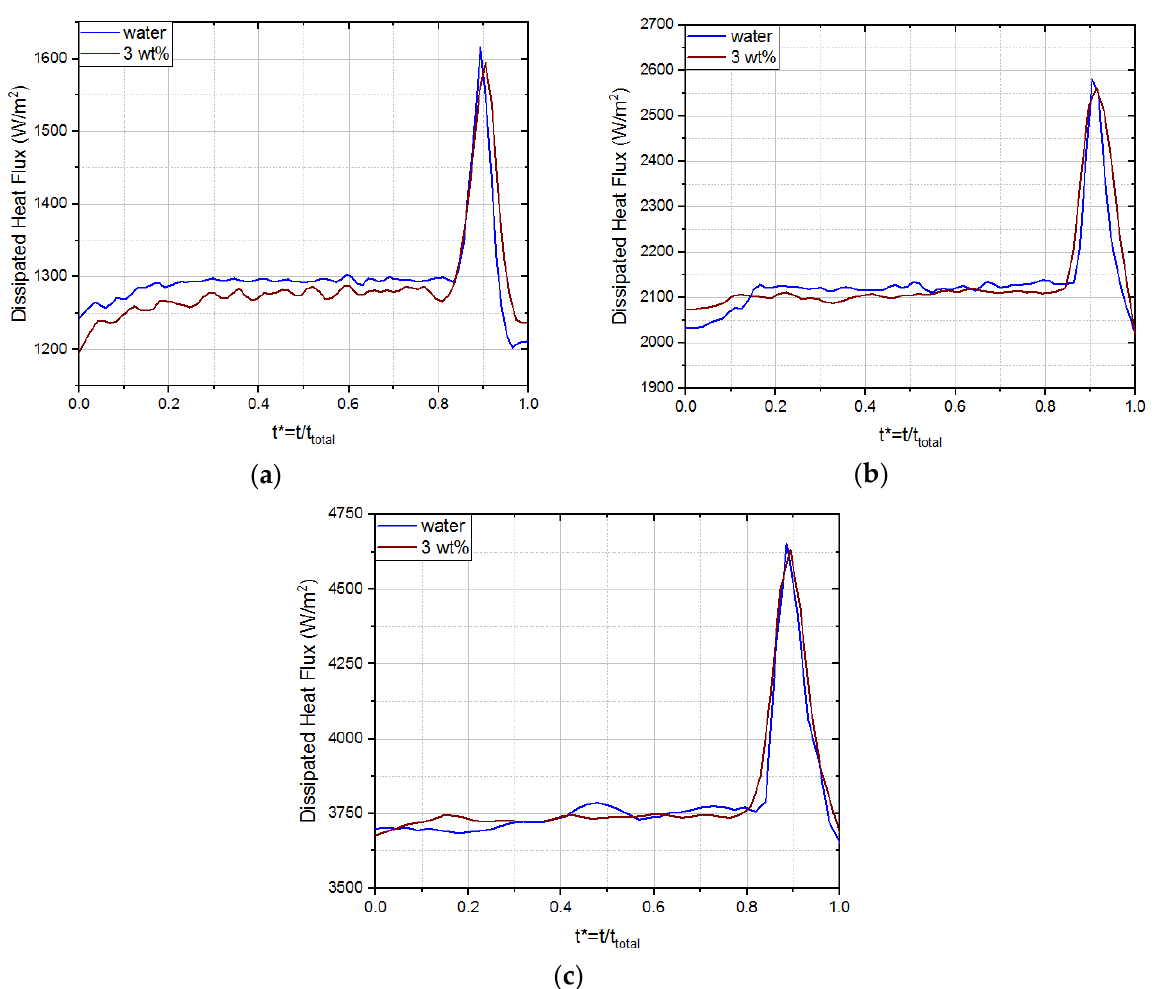
Figure 8. Average dissipated heat flux for a nucleation time frame, for different imposed heat fluxes, using water and 3 wt% concentration Al 2 O 3 /water nanofluid. Multiple superhydrophobic spots configuration. ( a ) 1290 W/m 2 (7 A). ( b ) 2132 W/m 2 (9 A). ( c ) 3790 W/m 2 (12 A).